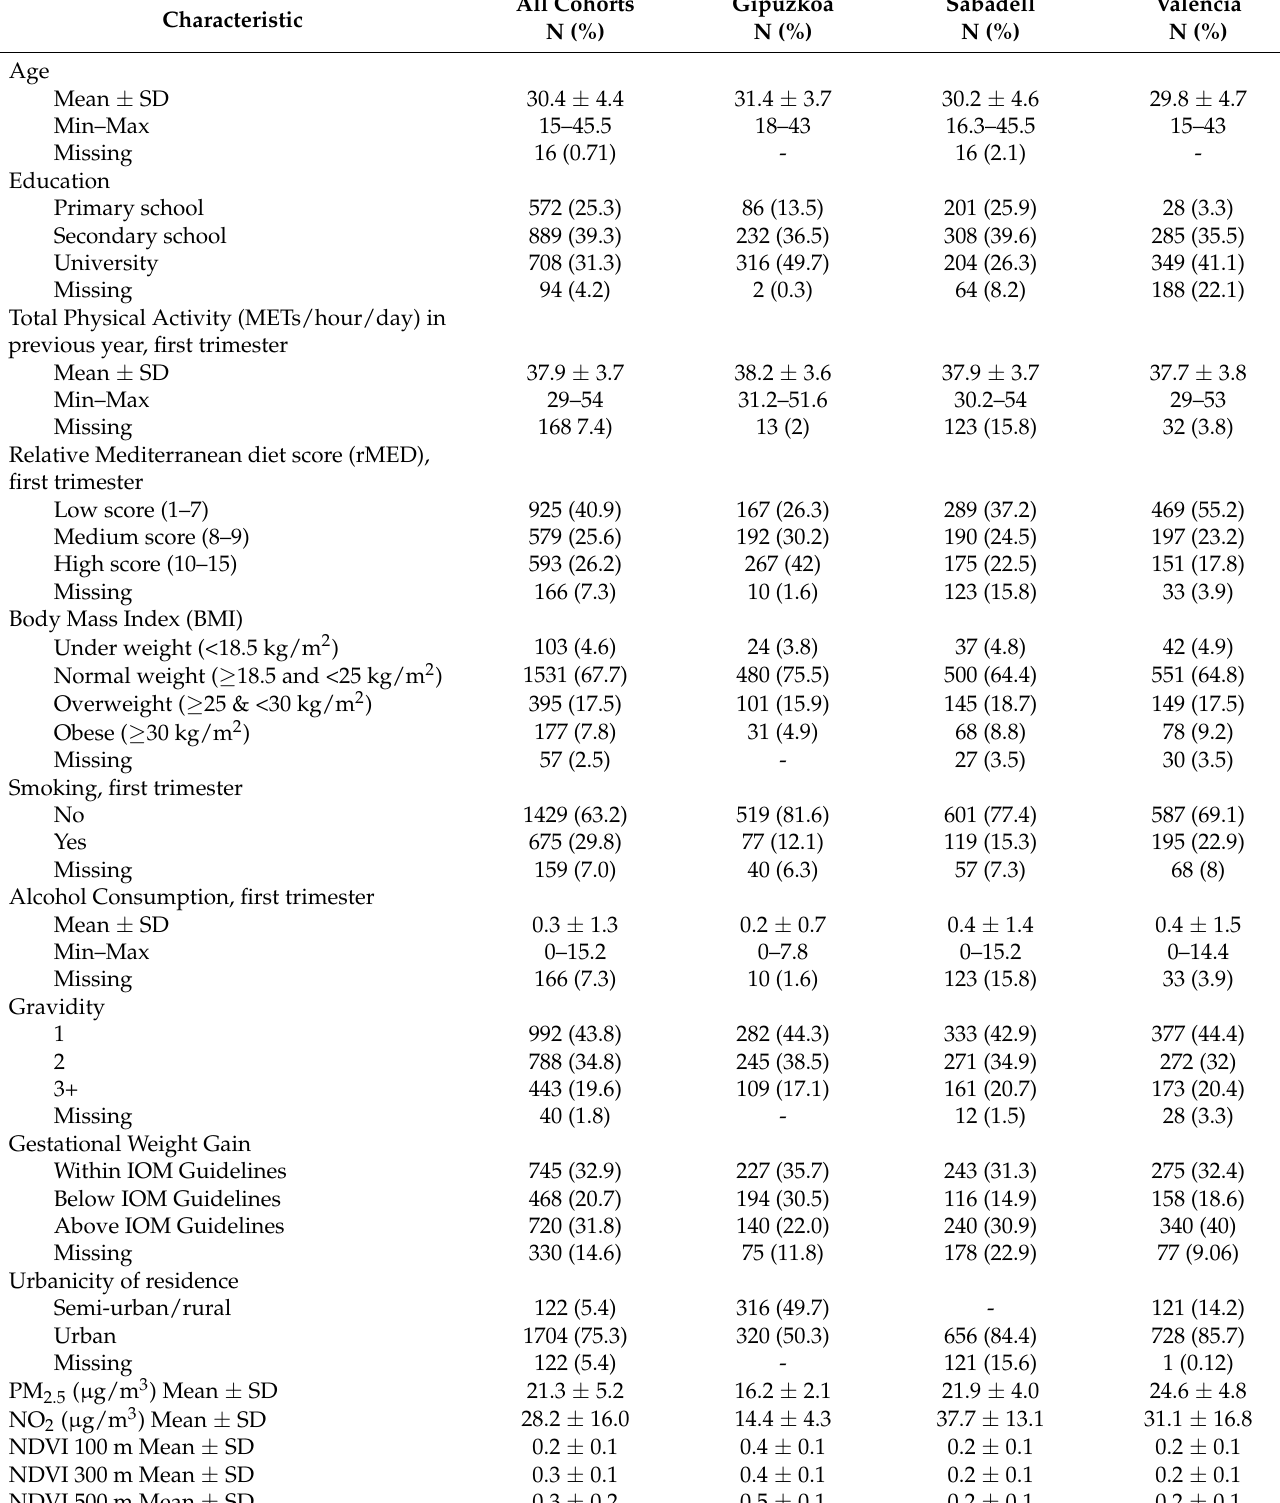
Table 1. Selected demographic and lifestyle characteristics and exposures during pregnancy, INMA Cohort,